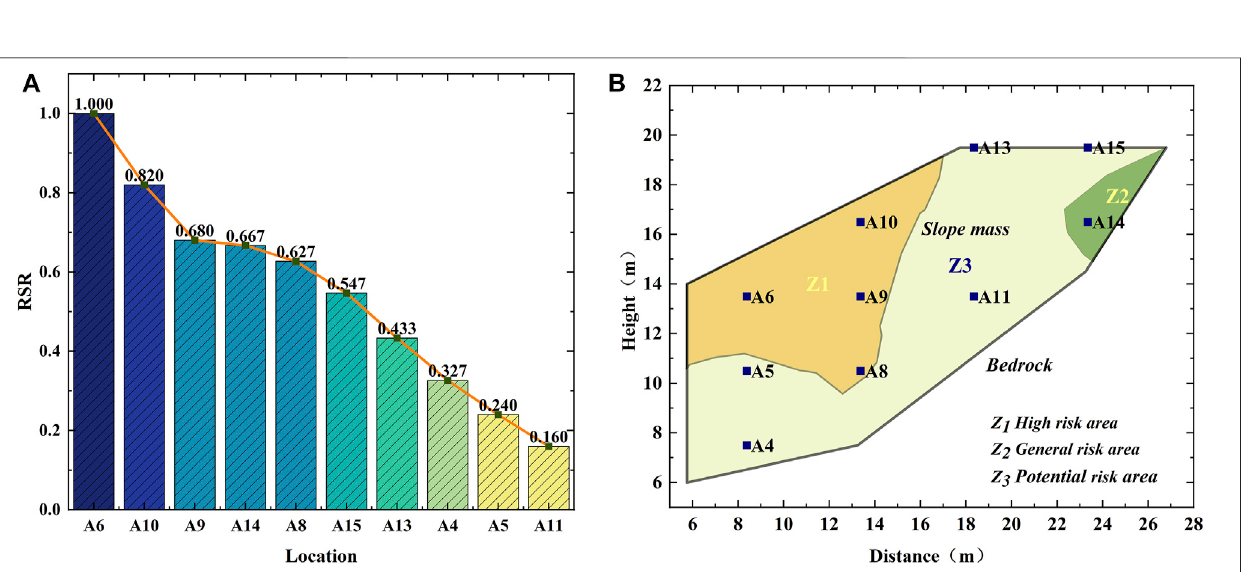
Frontiers in Earth Science |